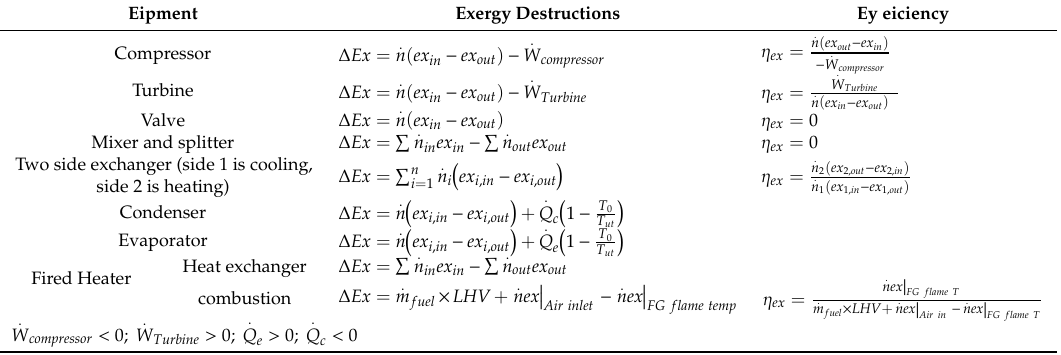
Table 1. Exergy destructions of di ff erent process control